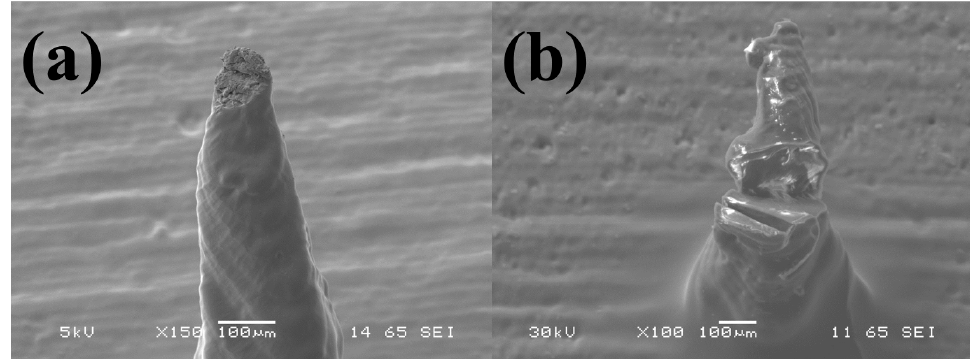
Figure 17. SEM images for the mechanical failure testing of the microneedles (MNs) with ( a ) breakage of the tip observed from forces of ~30 N and a ( b ) complete failure obtained at values of ~40